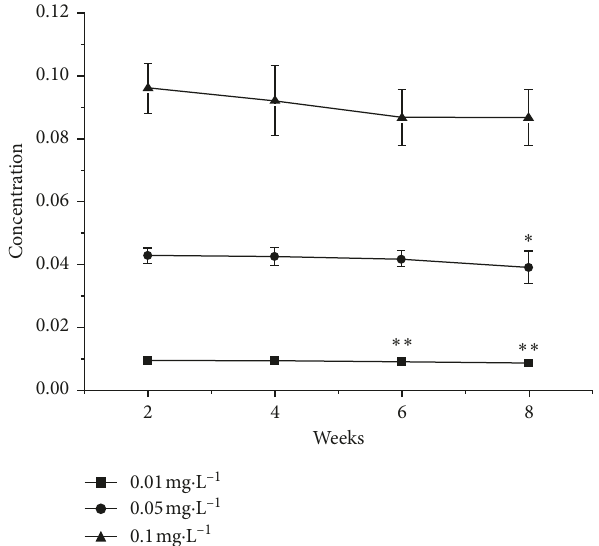
Figure 6: Storage stability of the difenoconazole concentration in mango extract solution at 4 ° C over time (weeks). Concentrations are presented as the mean percentage compared to the initial values. Values significantly lower than the initial controls are indicated with a single asterisk (LSD test, p 0 . 01). Error bars are standard errors of the means asterisk ( ( n ∗∗ (cid:30) <